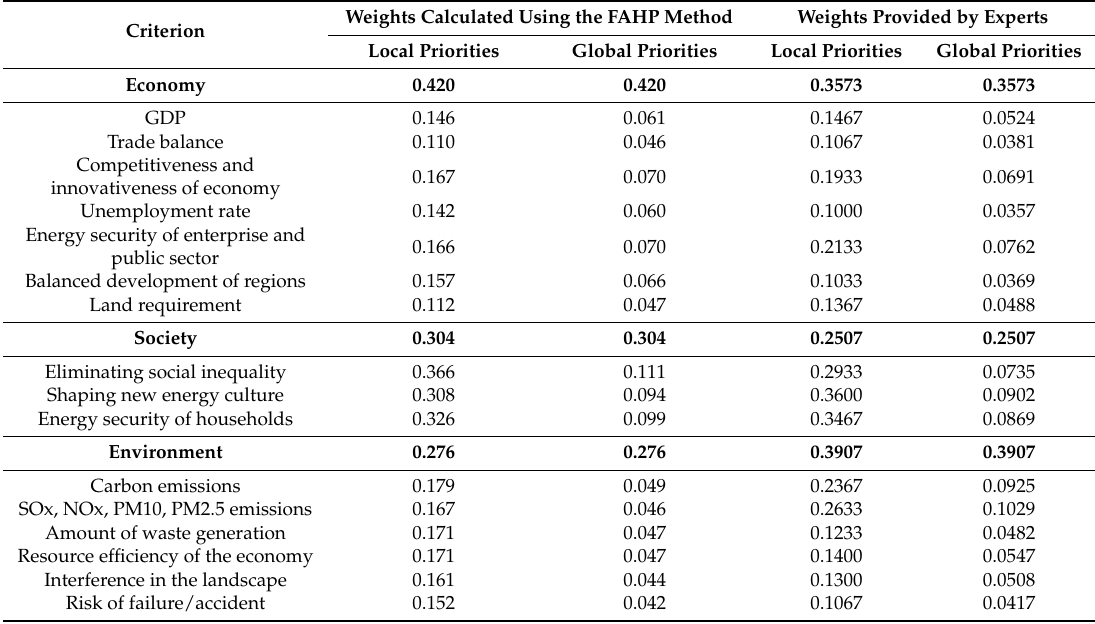
Table 10. Comparison of weights derived from the FAHP method and weights given by experts.